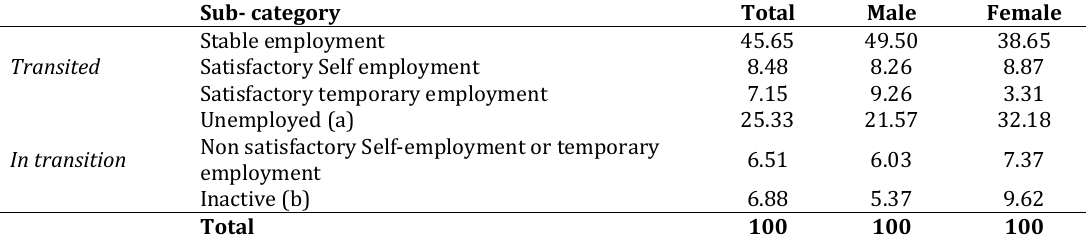
Table 1: Youth in transition and transited by sub-category and by gender (%) Sub- category Total Male Stable Transited